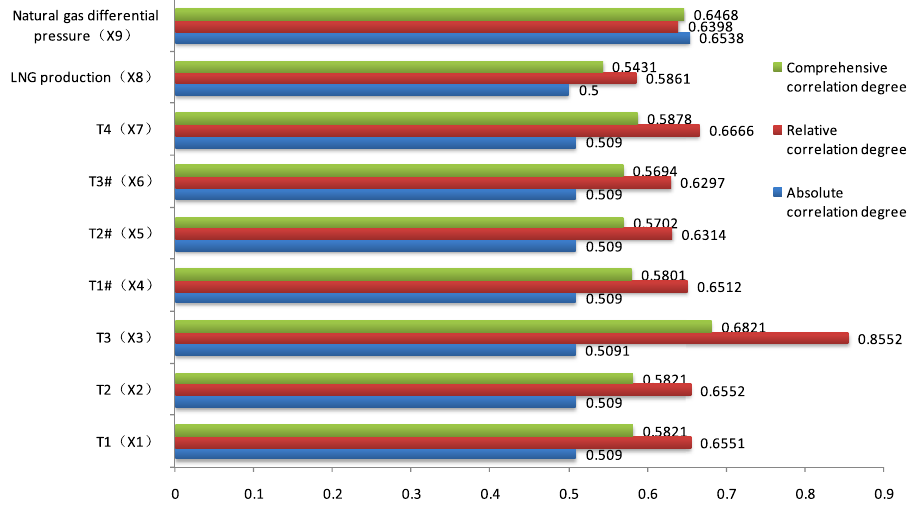
Fig. 3 Calculation results of grey correlation